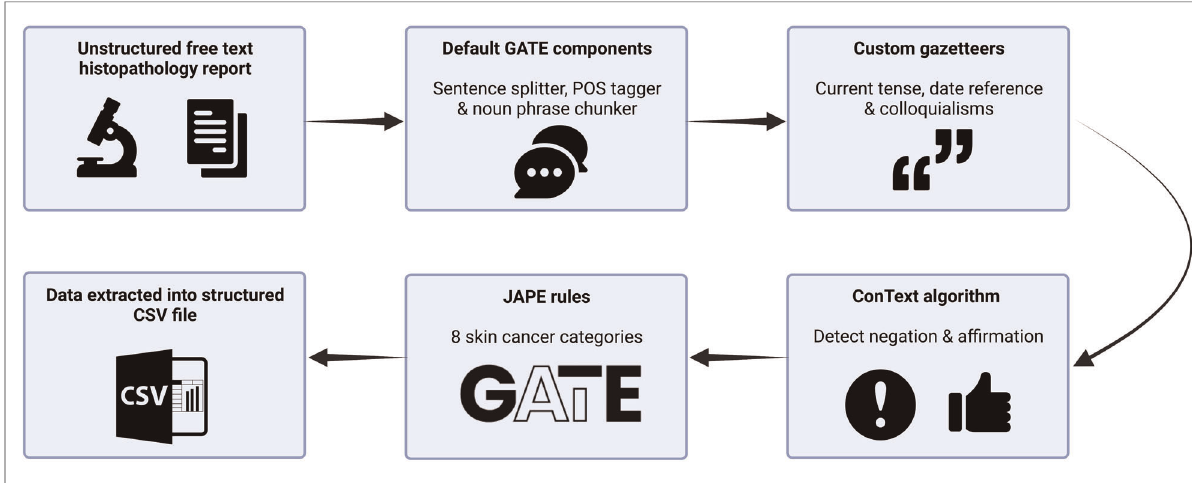
FIGURE 1 Schematic representation of our rule-based named entity recognition Natural Language Processing system for BCC histopathology reports. CSV, comma-separated values; JAPE, java annotation patterns engine